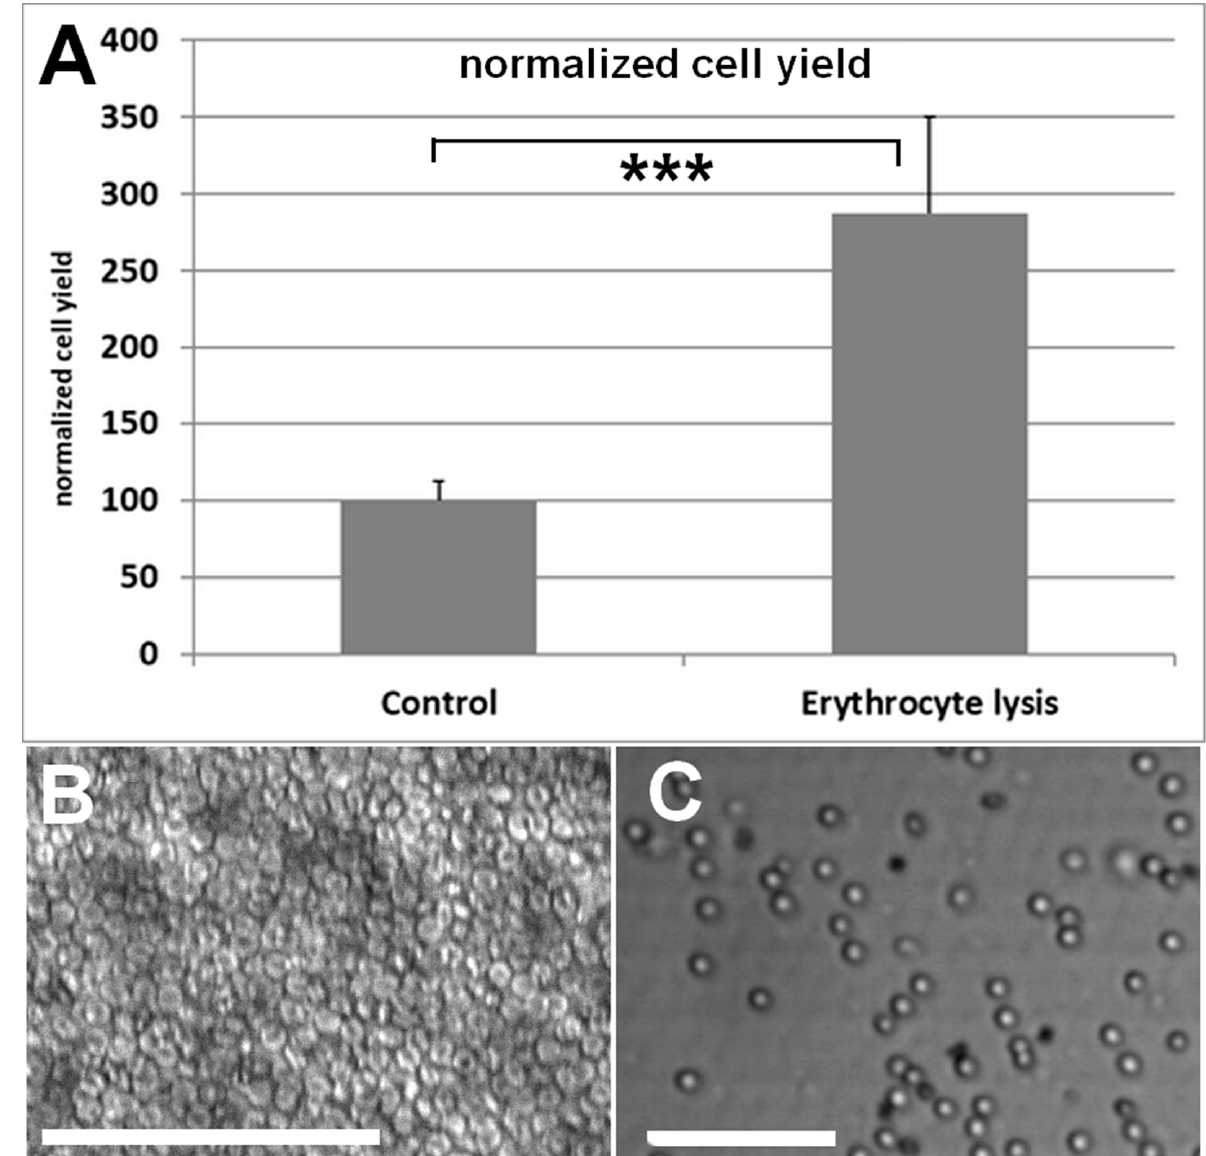
Figure 3. ( A ) Cell yield is increased more than 2.5-fold per mL when cells are incubated with an erythrocyte lysis buffer after stem cell isolation and prior to seeding. For this comparison, the counting of adherent cells after 24 h was used. Results are shown as mean ± SD. Student’s t-test was used to assess statistical significance (***: p < 0.001). ( B ) Representative image of seeded cells directly after seeding without red blood cell lysis buffer. The whole surface is covered with erythrocytes. ( C ) Representative image of seeded cells directly after seeding with red blood cell lysis buffer. Although many erythrocytes remain in the suspension, there is free surface area for the adipose tissue cells to adhere. The bars measure 100 µm.